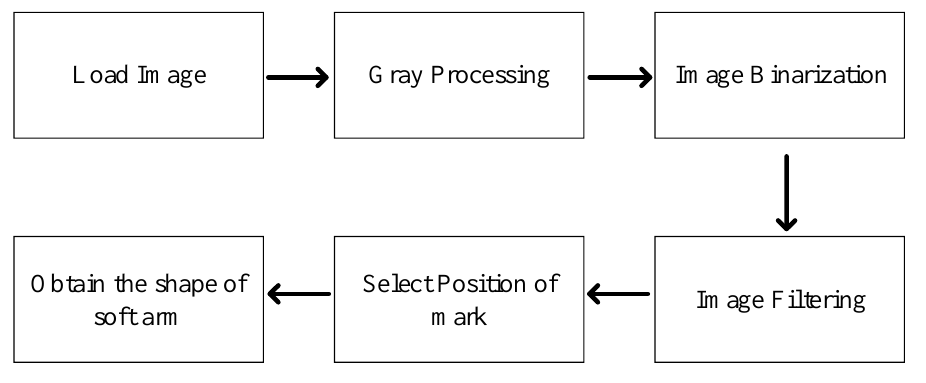
Figure 7. Image processing diagram.